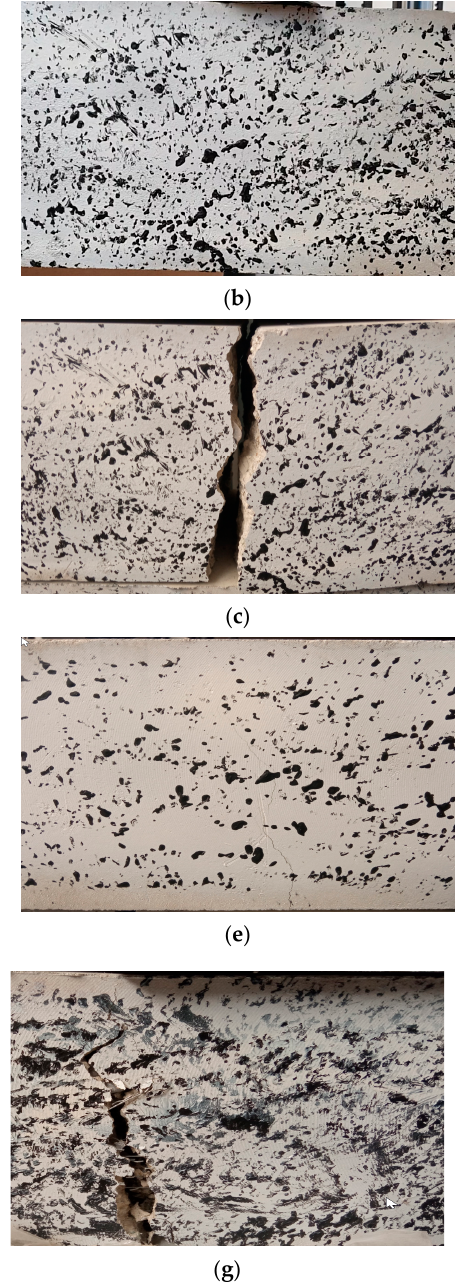
Figure 2. Results of three-point bending tests of analysed specimens: ( a ) force–displacement relationships, view of samples—for small strain: ( b ) A 1 , ( d ) A 2 , ( f ) A 3 , after testing for material: ( c ) A 1 , ( e ) A 2 , ( g ) A 3 . Table 2. Results obtained from three-point bending tests of fibre concrete specimens. Specimen